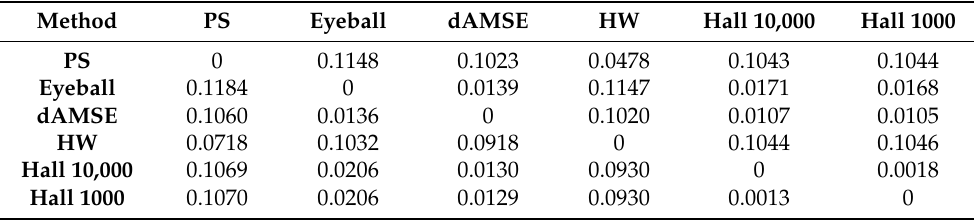
Table 5. The mean absolute differences (MAE) of the threshold estimates in the left tail (below diagonal) and right tail (above diagonal) for five methods.